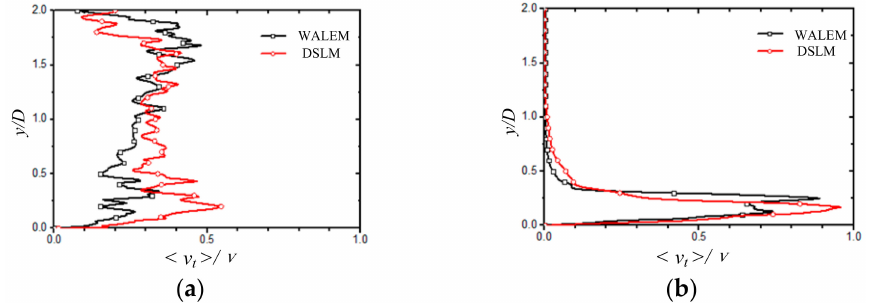
Figure 3. The ratio of the sub-grid viscosity to the molecular viscosity at r / D = 0 and r / D = 1; ( a ) r / D = 0; ( b ) r / D = 1.